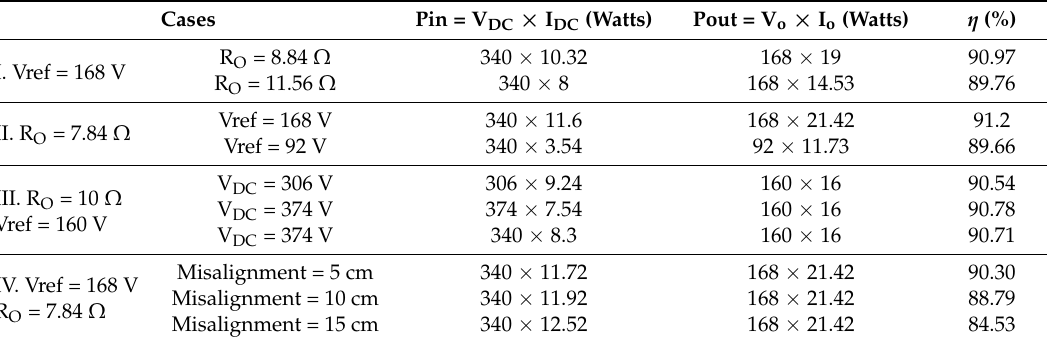
Table 2. DC-DC Efficiency for All the Test